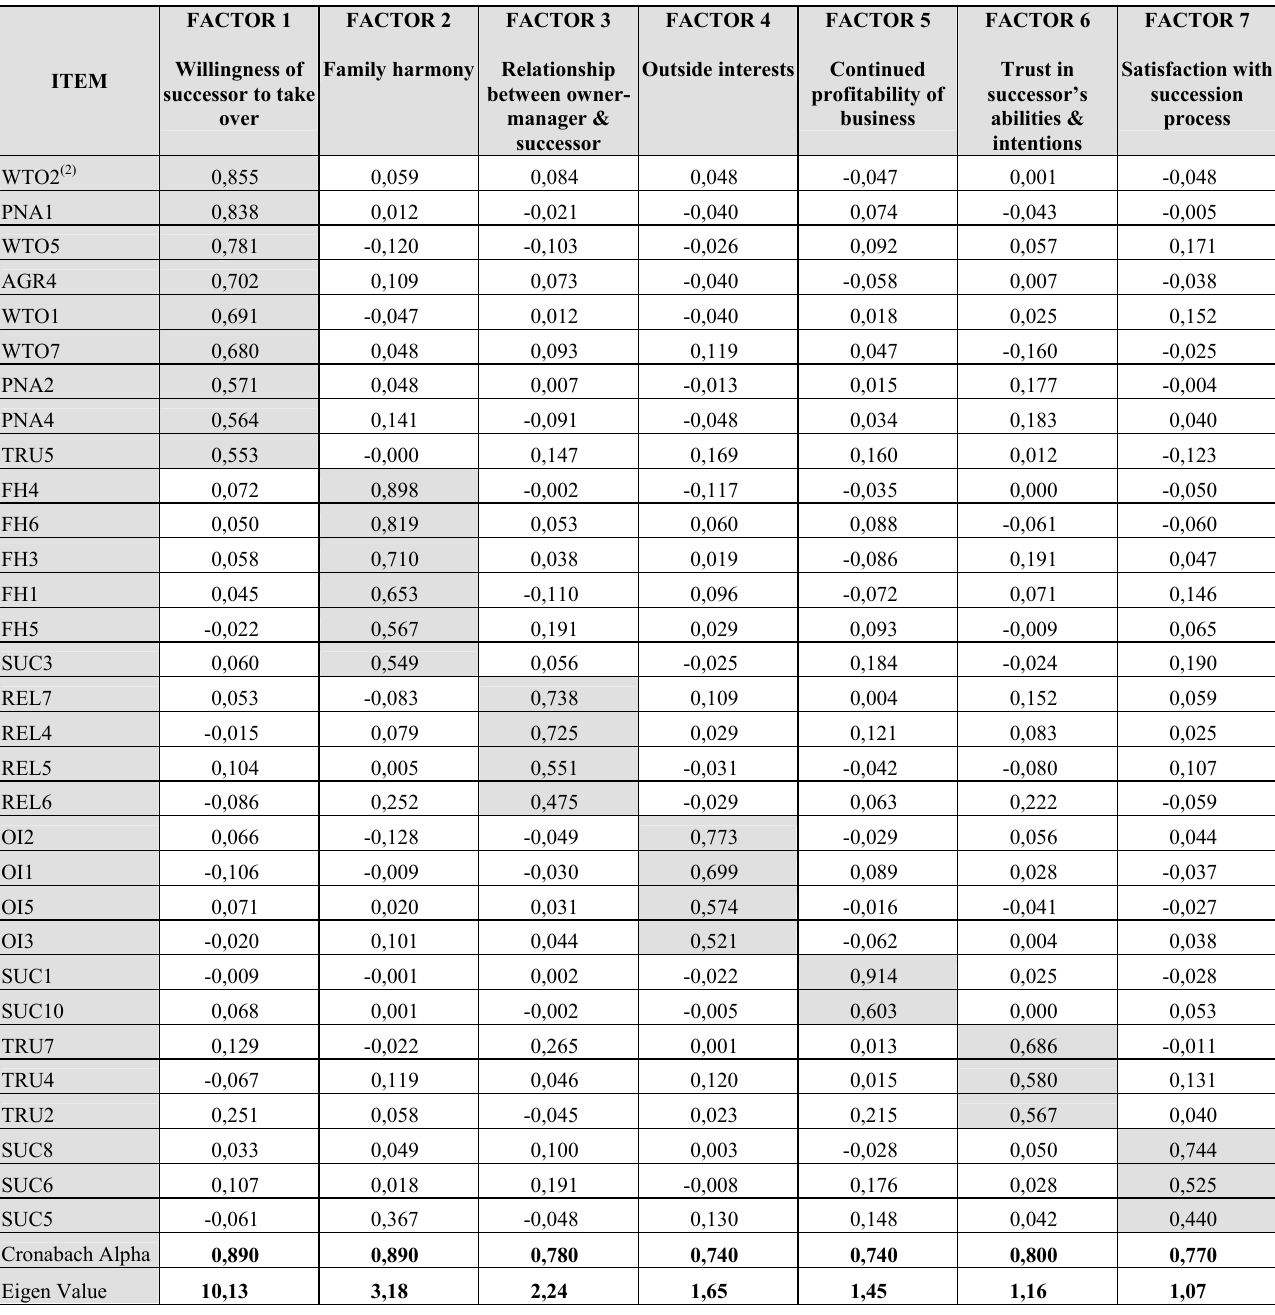
Table 1: Exploratory factor analysis result